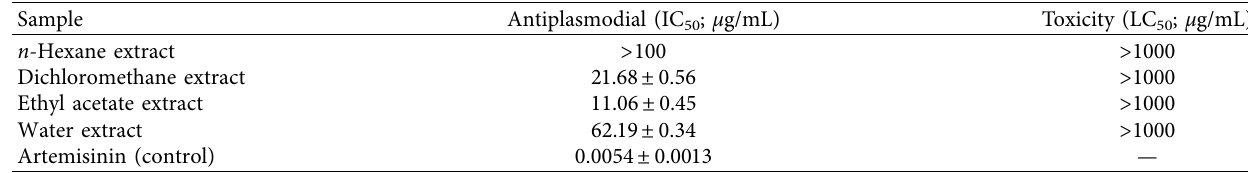
Table 2: Antiplasmodial activity and toxicity of S. palustris (Burm.f.) Bedd. extracts.